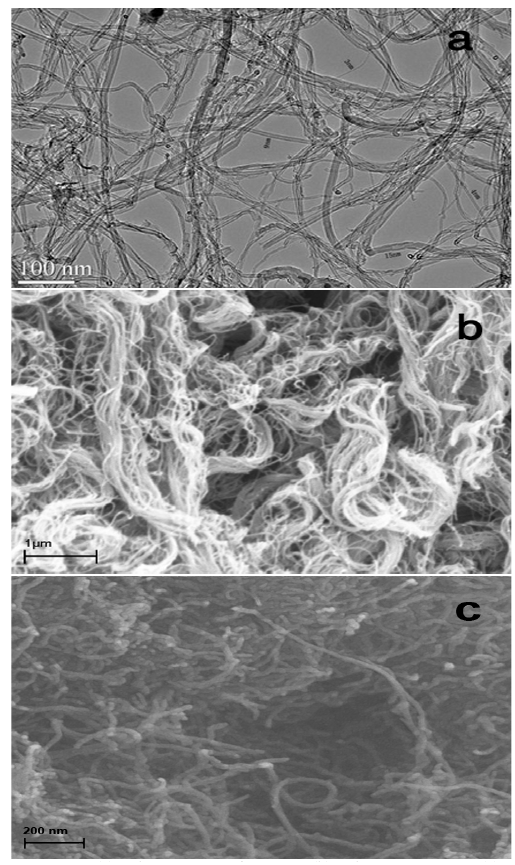
Fig.3. Pore size distribution of the MWCNT using the BJH method. Fig. 3. Pore size distribution of the MWCNT using the BJH